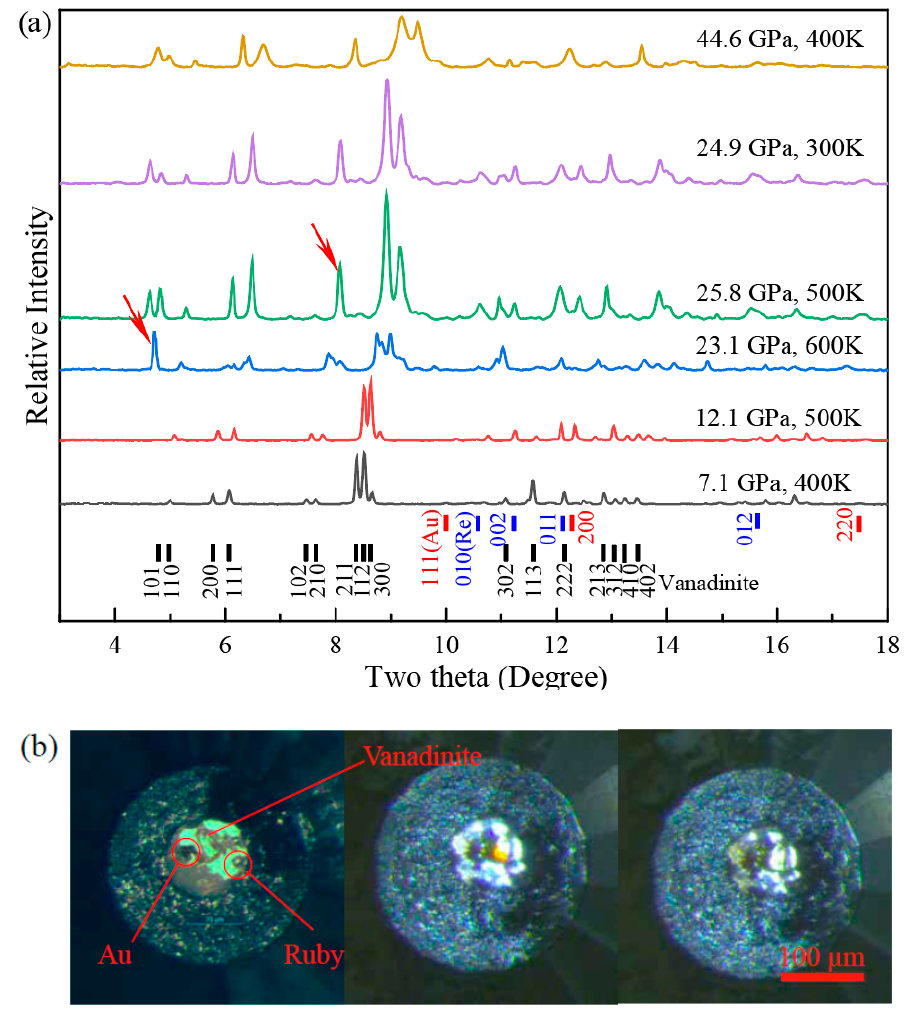
Figure 3. Selected XRD patterns and color change of vanadinite. ( a ) Representative integrated XRD patterns at different pressures and temperatures. The black short lines are peaks of vanadinite. The Red short lines are indexed peaks of pressure calibration Au. The blue short lines are due to gasket (Re) reflections. The red arrows indicate the new peaks who appear at different conditions. The wavelength of the X-ray is 0.43409 Å. ( b ) Color changes of vanadinite, which was transparent at 7.1 GPa before the XRD experiment (left image), reddish during the decompression after experiment (center image), and then back to transparent at ambient conditions after decompression (right image).